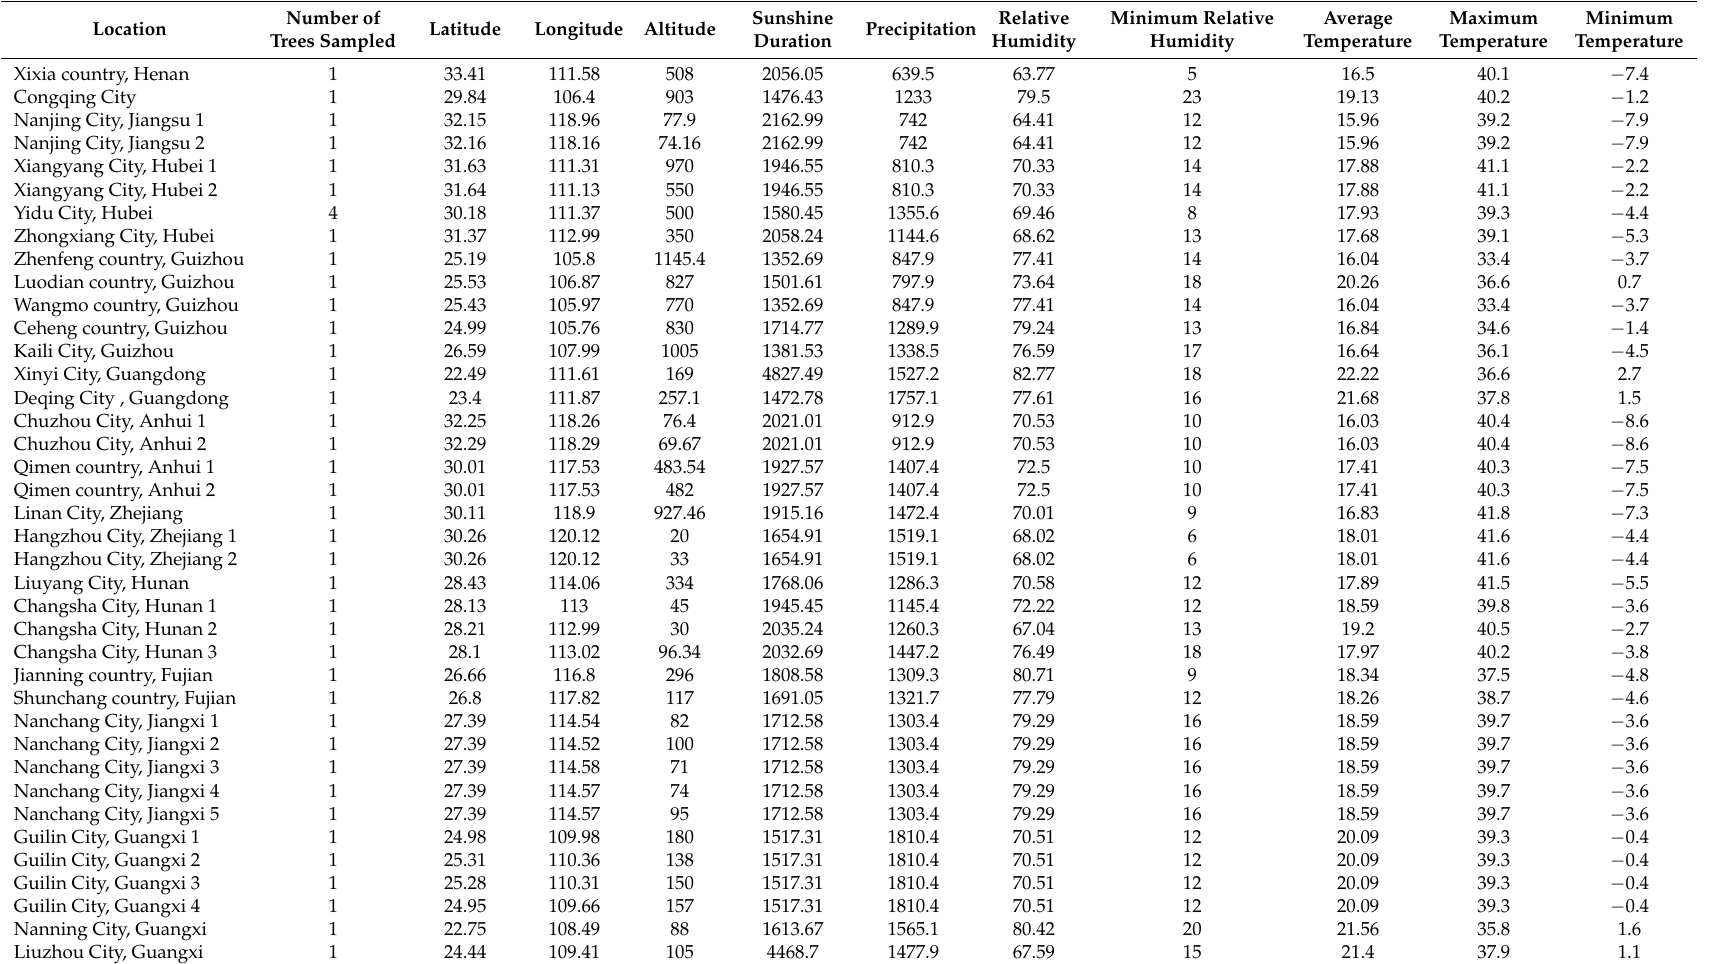
Table 1. Collection locations of Sapindus mukorossi fruit and associated environmental